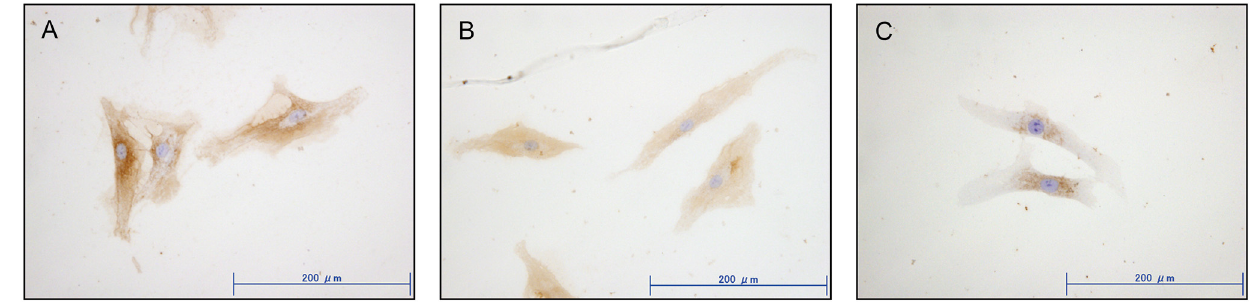
Fig 1. Effect of hyaluronan oligosaccharides (HAoligos) on endogenous HA deposition in rheumatoid synovial fibroblasts (RSFs). HA accumulation in RSFs after treatment with or without HAoligos was visualized by diaminobenzidine (DAB) staining using a biotinylated HA binding protein. A , Control medium. B , 250 mg/ml HAoligos. C , 400 units/ml bovine testicular hyaluronidase. Original magnification × 400, scale bar: 200 μ